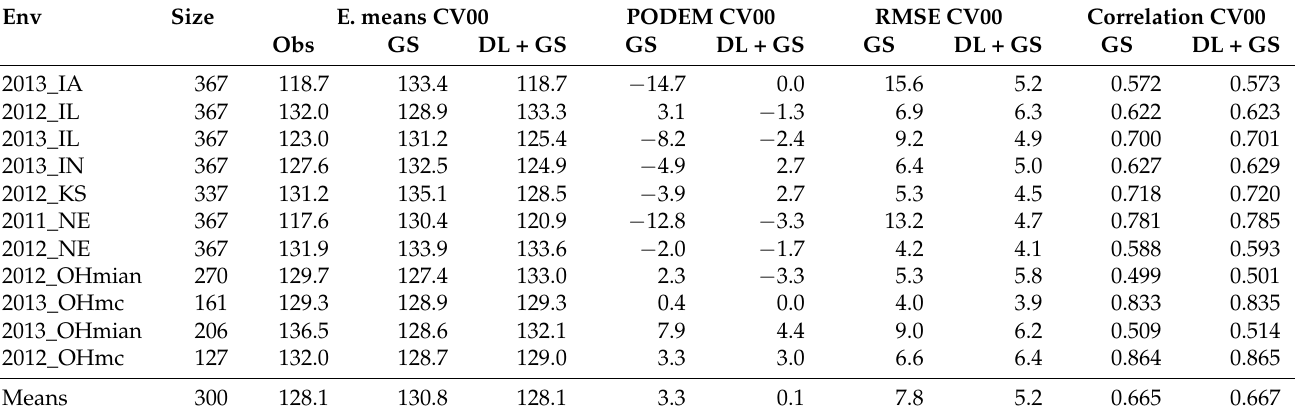
Table 2. Observed and predicted environmental means of days to maturity (DTM) under the CV00 scheme (predicting untested genotypes in unobserved environments) using the conventional GP model and the CB-method, and their corresponding predicted vs. observed difference in the environ- mental means (PODEM), root-mean-square error (RMSE), and Pearson correlations for 367 genotypes observed in 11 environments in the US North-Central